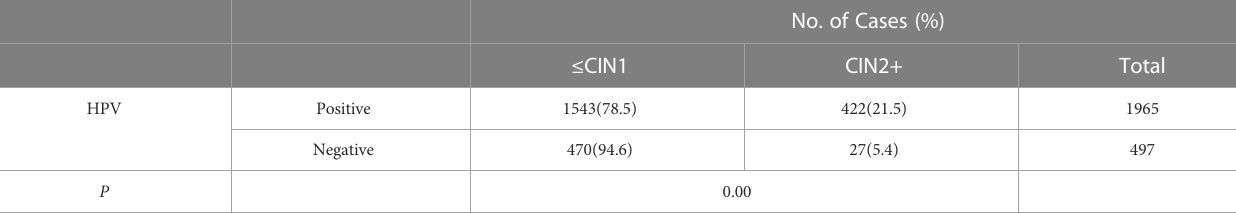
TABLE 3 The histopathologic results for positive and negative HPV women with ASC-US.